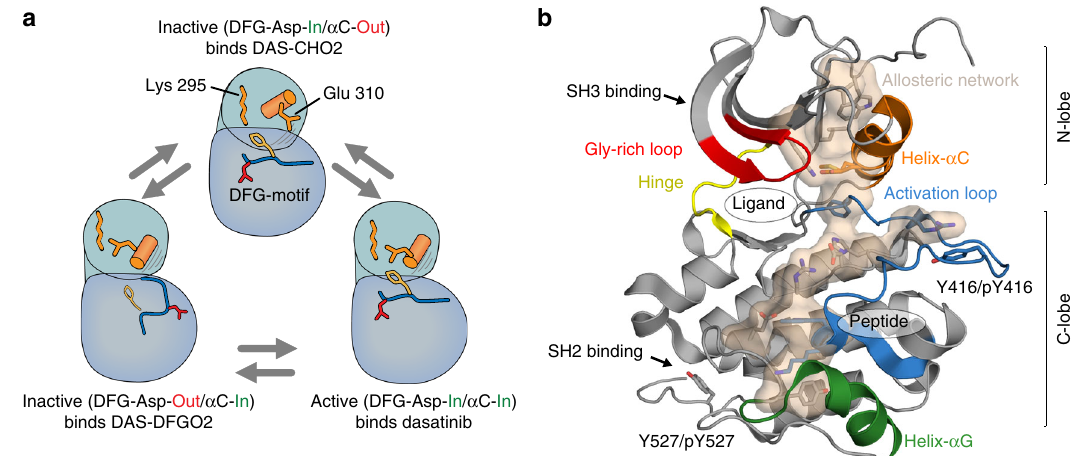
Fig. 1 Src can adopt distinct conformations and integrates diverse inputs that regulate its kinase activity. a Distinct active and inactive conformations are induced when SrcKD binds to conformation-selective ligands. Dasatinib stabilizes the “ DFG-Asp-in/ α C-in ” active conformation, whereas DAS-DFGO2, and DAS-CHO2, stabilize the “ DFG-Asp-out/ α C-in ” and “ DFG-Asp-in/ α C-out ” inactive conformations, respectively. b In Src, allosteric communication between the ATP-, substrate peptide-binding sites and the regulatory sites is propagated through an allosteric network (stick and surface representation) that was previously identi fi ed from MD simulations 19 . This network spans the kinase domain from the N-lobe to the C-lobe and includes catalytic and regulatory elements, and suggests a mechanism for integrating diverse regulatory input